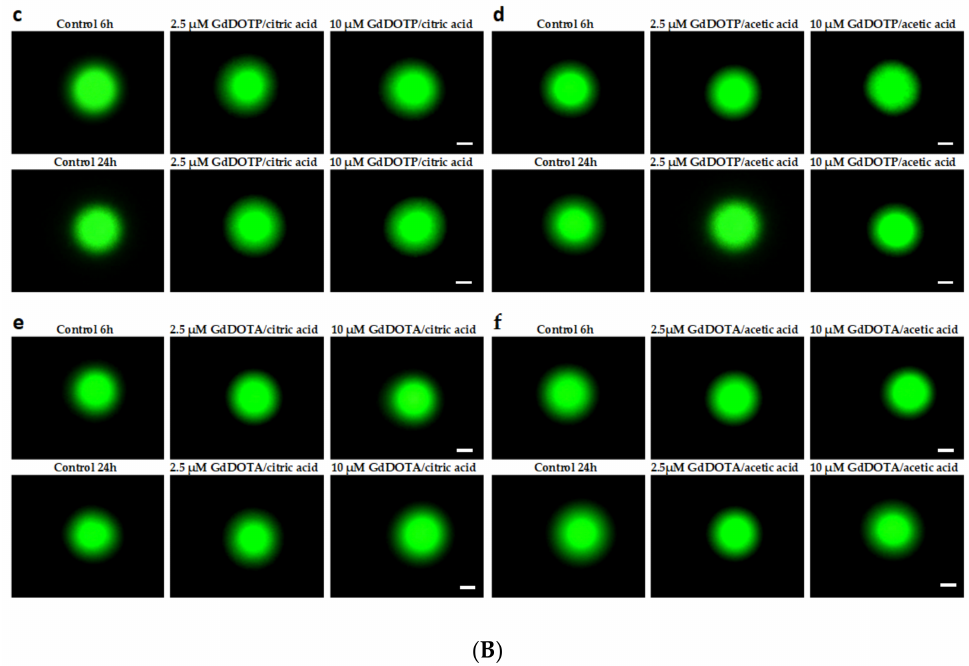
Figure 6. ( A ) Representative fluorescence images of SVEC4-10 cells in the presence of increased concentrations of ( a ) GdDOTP citric acid, 2.5 mg · mL − 1 CS; ( b ) GdDOTP acetic acid, 2.5 mg · mL − 1 CS after 6 and 24 h. Unloaded CS-TPP/HA NGs obtained in citric and acetic acid were used as controls. Scale bar = 50 µ m. Magnification, × 100. The green fluorescence intensity were analysed and quantified using the OpenComet program; ( B ) Representative fluorescence images of SVEC4-10 cells, in the presence of increased concentrations of, ( c ) GdDOTP citric acid, 1.5 mg · mL − 1 CS, ( d ) GdDOTP acetic acid, 1.5 mg · mL − 1 CS, ( e ) GdDOTA citric acid, 1.5 mg · mL − 1 CS, ( f ) GdDOTA acetic acid, 1.5 mg · mL − 1 CS after 6 and 24 h. Unloaded CS-TPP/HA NGs obtained in citric and acetic acid were used as controls. Scale bar = 50 µ m. The green fluorescence intensity were analysed and quantified using the OpenComet program. Magnification, × 100.